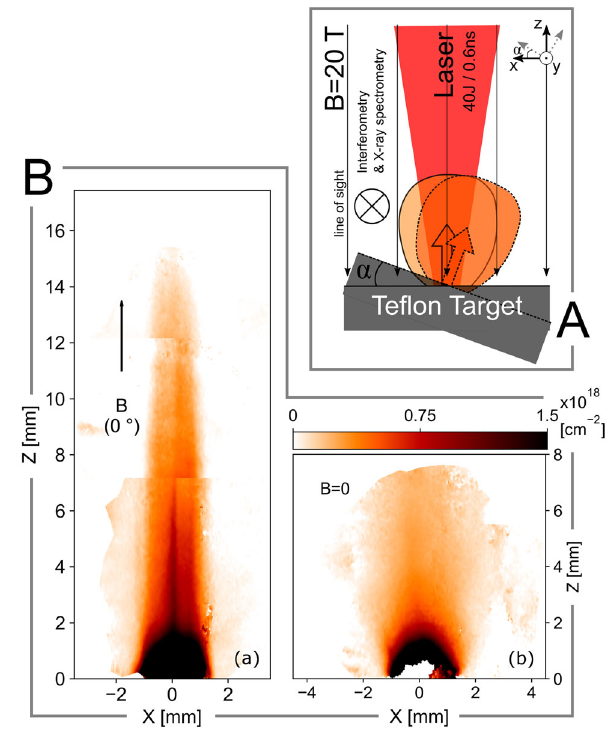
Fig. 1 Schematic of experimental set-up and observed plasma expansion, with and without an aligned magnetic fi eld. A : Sketch of the experimental setup. The target is embedded in a large-scale 20 T magnetic fi eld, and is heated by a I max ¼ 1 : 6 ´ 10 13 Wcm (cid:2) 2 , 0.6 ns duration laser. By tilting the target, it is possible to vary the angle α between the main plasma out fl ow direction and that of the magnetic fi eld. The plasma is optically probed along the y axis. B : a Laboratory maps of the electron density integrated along the probe line of sight, in [cm − 2 ], retrieved via interferometric measurement (see “ Methods ” section), at 28 ns after the start of the plasma expansion. The vertical black arrows indicate the magnetic fi eld direction; here aligned with the main axis of plasma expansion (i.e., along z ; z = 0 being the target surface). b Same without any magnetic fi eld